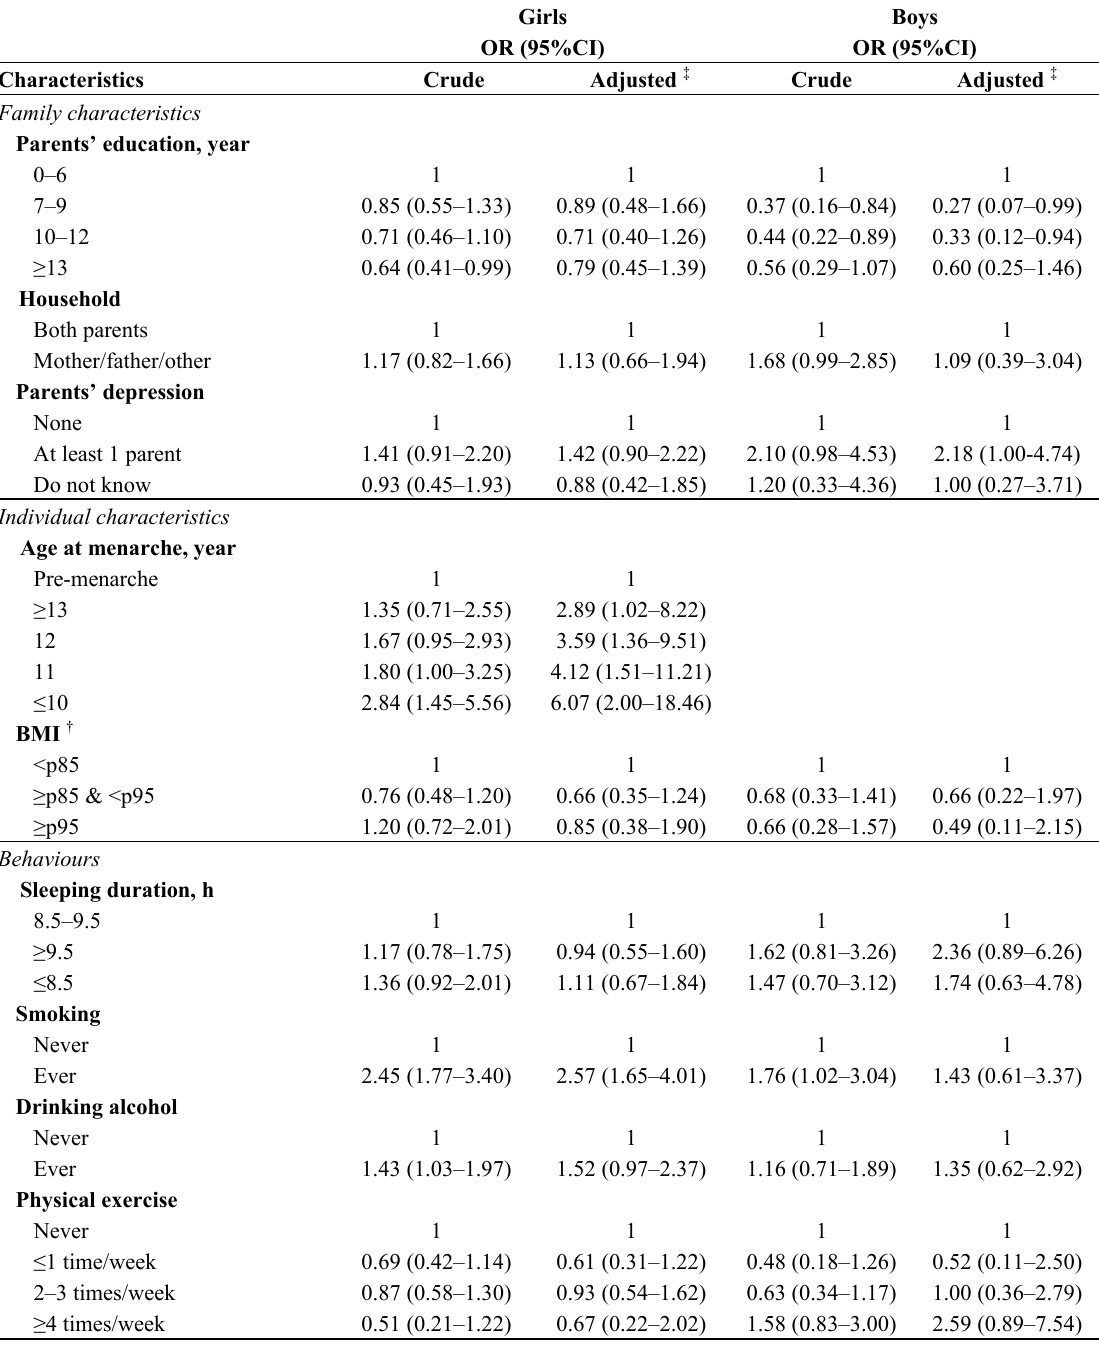
Table 3. Crude and adjusted odds ratios for depressive symptoms (BDI-II > 13), according to boys’ and girls’ characteristics (Porto, Portugal 2003–2004) (n =